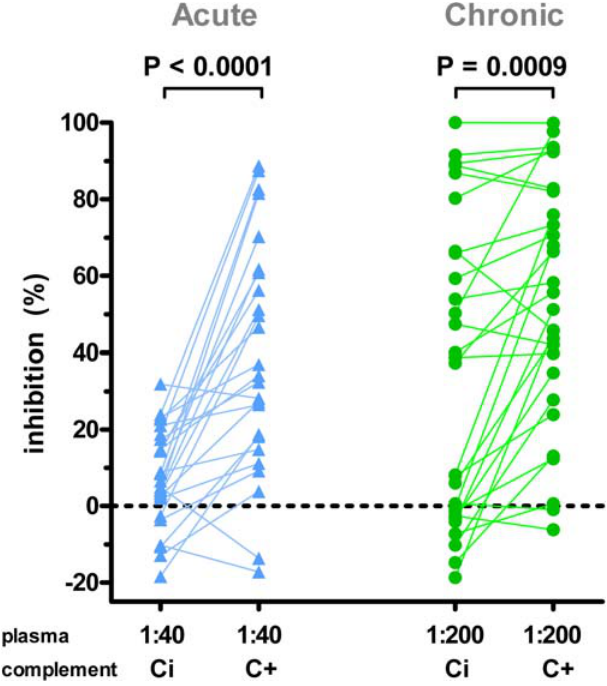
Figure 7. Influence of Complement on Viral Infectivity In Vitro Inhibitory activity of patient plasma against the heterologous virus JR-FL was measured in presence of active (C þ ) or heat-inactivated (Ci) complement on TZM-bl cells. Blue triangles denote acutely, green circles chronically infected patients. Data points are means of two independent experiments with plasma from the same patient. Differences in inhibition between inactivated and active complement within the subgroups were compared using Wilcoxon signed-rank test. The results demonstrate that complement increases the inhibitory activity of HIV specific antibodies in vitro.